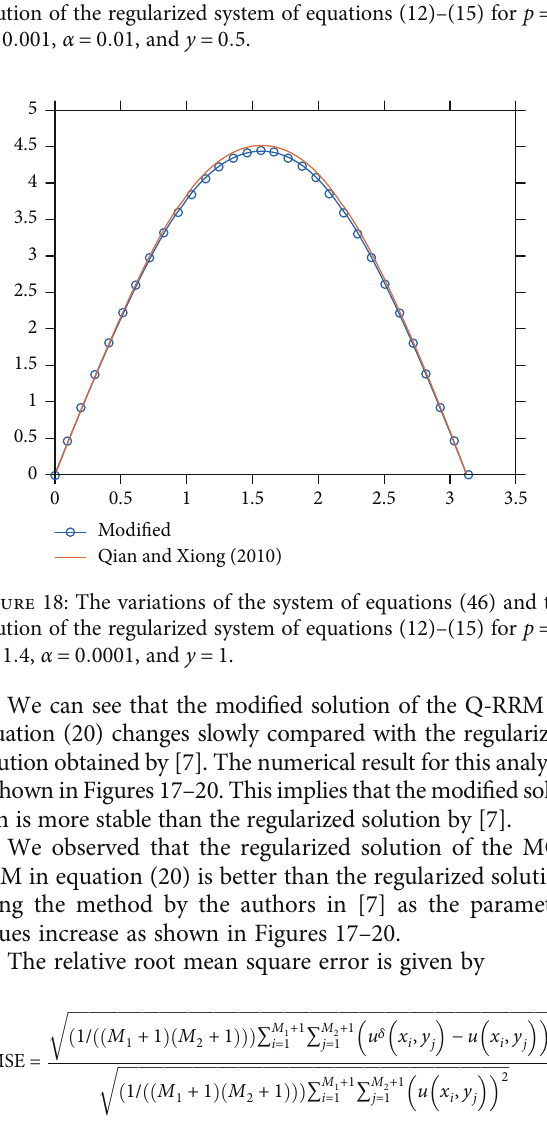
Figure 16: The variations of the system of equations (42) and the solution of the regularized system of equations (12) – (15) for p = 2 , k = 0 : 1 , α = 0 : 02 , and y = 1 .